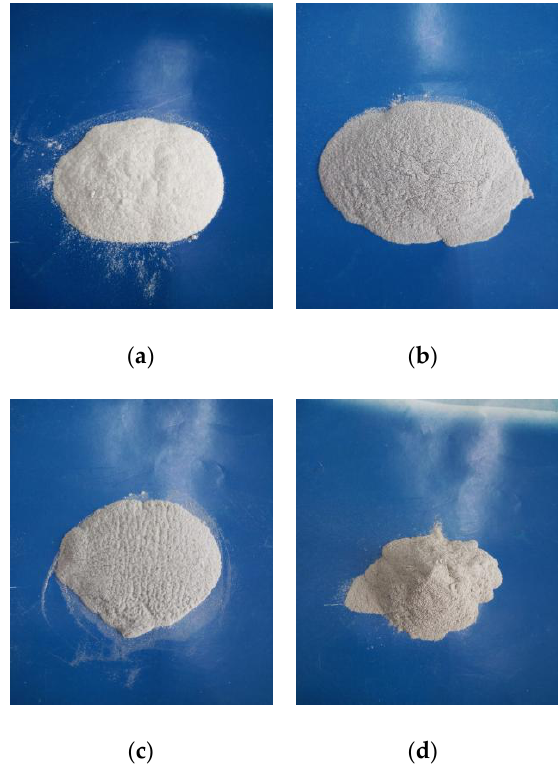
Figure 1. Optical images of the composite powder of wood flour, polyether sulfone (PES), and various amounts of carbon nanotubes (CNTs): ( a ) 0% CNT, ( b ) 0.05% CNT, ( c ) 0.1% CNT, and ( d ) 0.15% CNT.